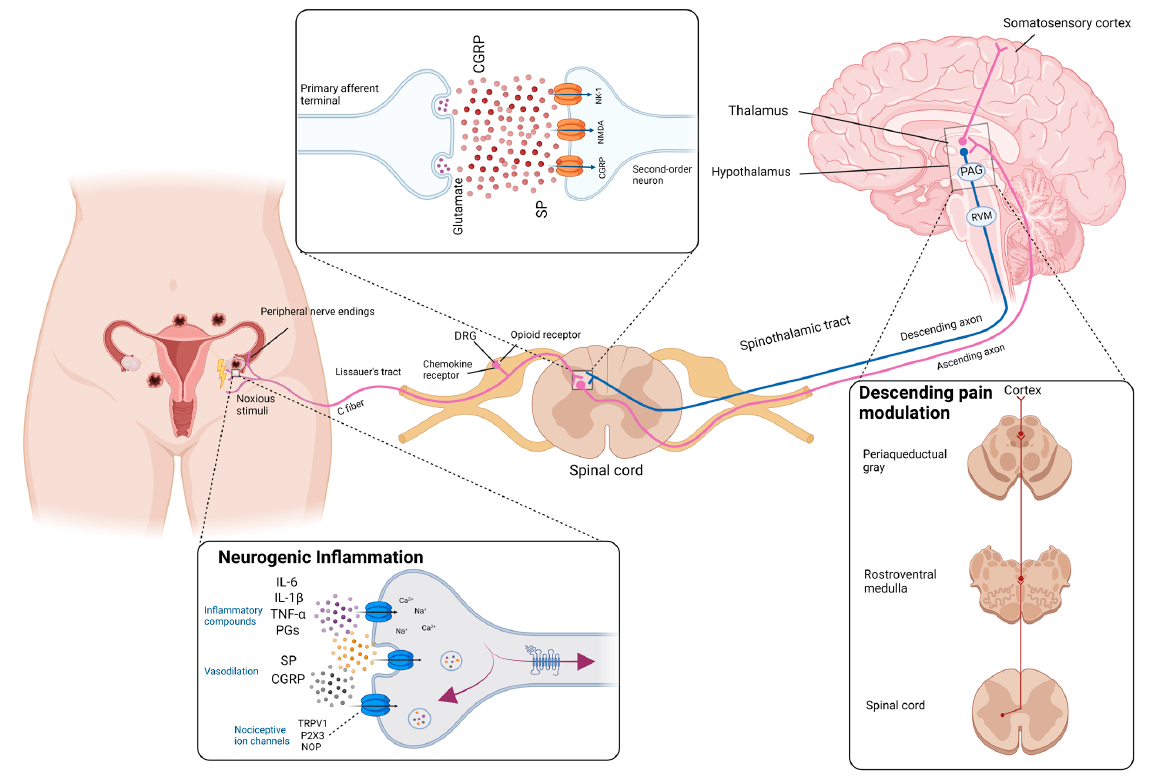
Figure 1. Pain and neurogenic inflammation in endometriosis. Endometriotic cytokines in the peritoneum, prostaglandins, interleukins (ILs), calcitonin gene-related peptide (CGRP), substance P (SP), nociceptive opioid peptide (NOP), and transient receptor potential vanilloid 1 (TRPV1) stimulate sensory peripheral nerve endings. The nociceptive signal conduct in the myelinated A δ fibers or unmyelinated C fibers to the spinal cord. Subsequently, opioid peptides, which are synthesized as chemokine receptors, promote an antinociceptive effect in the dorsal root ganglia (DRG). In the DRG, chemokine receptors and opioid receptors receive the nociceptive message and transfer it to the spinal cord. Within the spinal cord, neurotransmitters such as CGRP, SP, and glutamate are released to activate the second-order neurons. Then, CGRP will combine with the CGRP receptor complex and SP will act on the neurokine-1 receptor (NK-1). The noxious message travels up to the thalamus via ascending axons and then finally reaches the somatosensory cortex. The nociceptive input can be attenuated or facilitated through endogenous opioid release via a descending pain-modulated system, which includes two crucial structures, periaqueductal gray (PAG) and rostroventral medulla (RVM). Inflammatory pain is also a subtype of nociceptive pain [28,29]. EM is associated with a local inflammatory reaction in which regional inflammatory mediators such as cytokines, tumor necrosis factor-alpha (TNF- α ), interleukin (IL)-1 β , IL-6, and also immune cells are present in high concentrations [10,30]. The inflammatory mediators are secreted [12,30]. This is the result of longstanding chronic inflammation in which pain loses its func- tion as a barrier to noxious stimuli [32]. In addition, neuropathic pain is described in up to 75% of EM patients. Neuropathic pain is defined as pain caused by a lesion or disease of the somatosensory nervous system. The peripheral mechanisms of EM-associated pain are mainly focused on the interplay among the immune system, peripheral nerve system, and